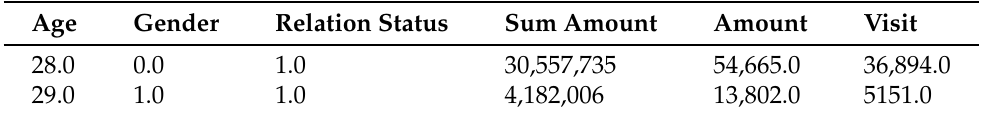
Table 9. Need based Package for Category E.